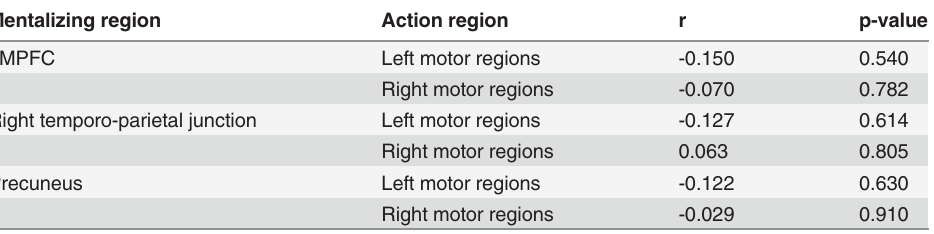
Table 3. Correlations between mentalizing and action regions for the reversed speech control data. Mentalizing region Action region r p-value aMPFC Left motor regions -0.150 Right motor regions 0.782 Right temporo-parietal junction Left motor regions -0.127 Right motor regions Precuneus Left motor regions -0.122 Right motor regions -0.029 0.910 Correlations between Mentalizing regressor activity in mentalizing regions and Action regressor activity in action regions. The r and p-values show that there are no signi fi cant correlations as observed in the ‘ normal ’ (non-reversed) data (reported in Table 2). Original p-values are reported (see Fig. 3 for an illustration). The responses in parts of the cortical motor network were summed over motor regions, as described in the methods